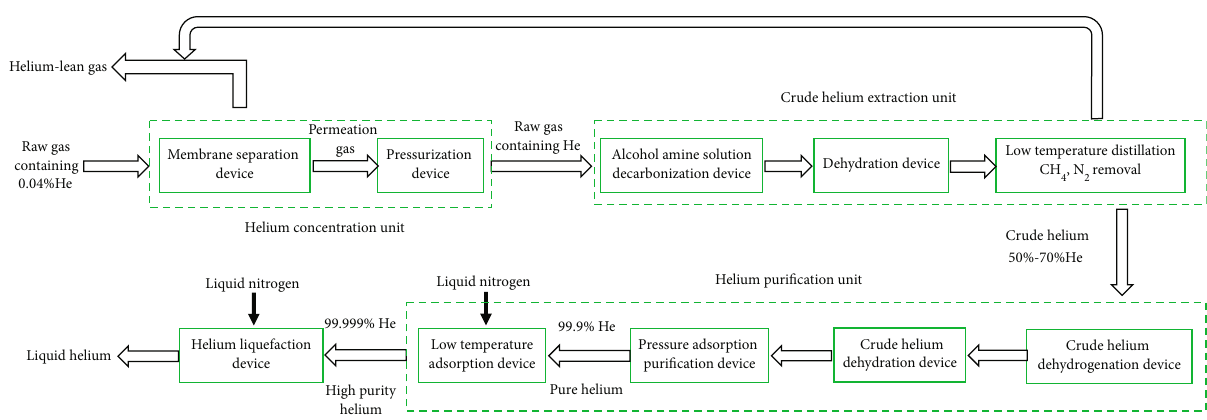
Figure 10: Flow of membrane separation and deep